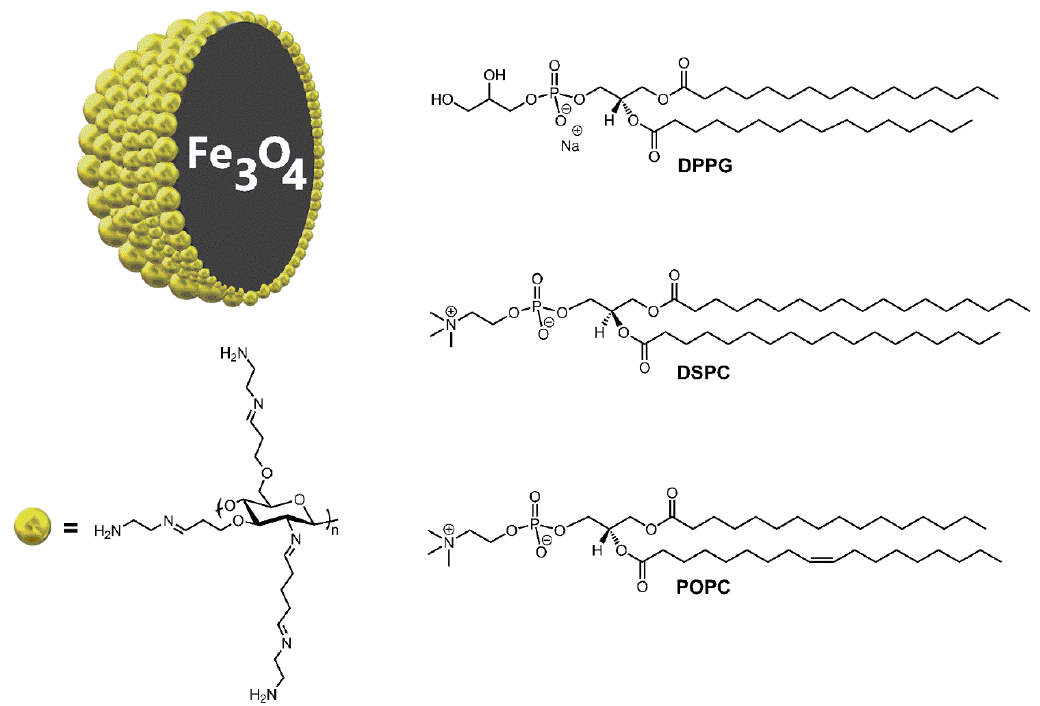
Figure 1. Molecular structure of the Fe 3 O 4 -AChit nanoparticles, 1,2-dipalmitoyl-sn-glycero-3-phospho-rac-(1-glycerol) (DPPG), 1,2-distearoyl-sn-glycero-3-phosphocholine (DSPC), and 2-oleoyl-1-palmitoyl-sn-glycero-3-phosphocholine